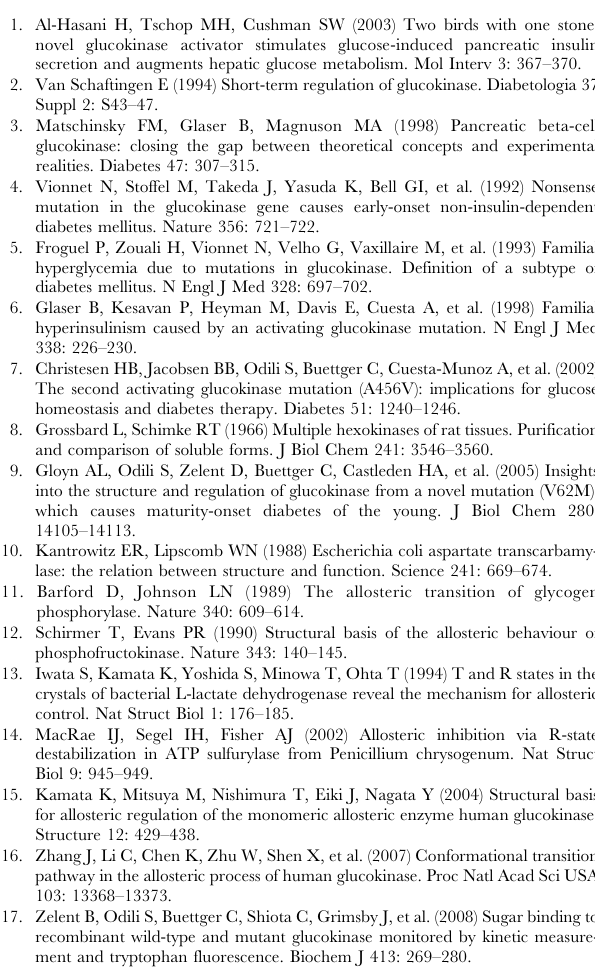
carbons in 1DGK, 1HKC and 1V4S are colored by yellow, pink and green, respectively. Found at: doi:10.1371/journal.pone.0006304.s003 (4.35 MB TIF) Figure S2 Time dependencies of the weighted Root-Mean- Square Deviations (wRMSDs) for the atoms of glucose (A), ATP (B) and GK (C) from their initial positions during the 10-ns MD simulation. (D) Residue fluctuations obtained by averaging atomic fluctuations over the MD simulation (black curve) and by computing the value from experimentally derived B factors (red curve) for GK crystal structure. (E) Time dependencies of energy during the 10-ns MD simulation. Found at: doi:10.1371/journal.pone.0006304.s004 (1.89 MB TIF) Figure S3 SDS-PAGE for the purified wild-type hLGK2 and its K169A mutant proteins (M: Marker; WT: wild-type hLGK2; K169A: hLGK2 K169A mutant). The molecular weight of wild- type hLGK2 and hLGK2 K169 mutant proteins were evaluated as about 52 kDa indicating by the standard protein markers, which is in agreement with the calculated mass (52 kDa). Found at: doi:10.1371/journal.pone.0006304.s005 (8.41 MB TIF) Figure S4 CD spectra of recombinant wild-type hLGK2 and K169A mutant proteins. Far-UV CD spectra of recombinant proteins were monitored at the concentration of 5 m M/L in 20 mM NaH 2 PO 4 buffer (pH 7.1). Found at: doi:10.1371/journal.pone.0006304.s006 (0.66 MB TIF)